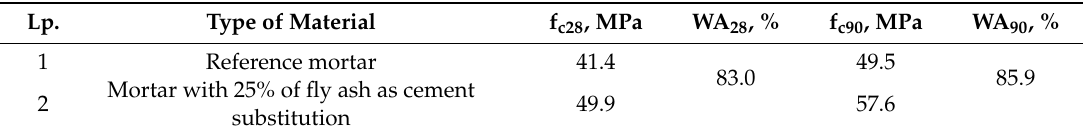
Table 4. Activity index (according to PN-EN 450-1) for calcareous fly ash, f c28 , f c90 —compressive strength after 28 and 90 days; WA 28 , WA 90 —calculated as a compressive strength of reference mortar and fly ash mortar ratio in %.